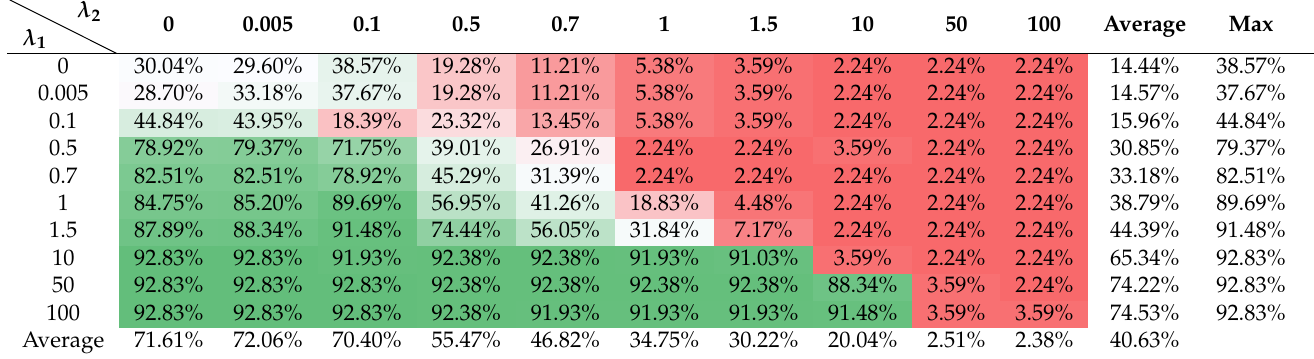
Table 7. Accuracy of transferring D S by TFCM.